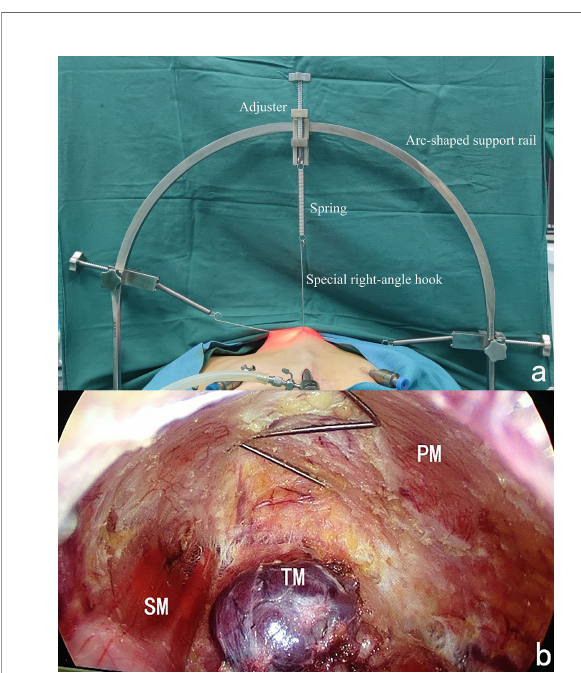
FIGURE 4 | (A) Outer schematic diagram of the use of the “ elastic stretch cavity builder ” . (B) Inner schematic diagram of the use of the “ elastic stretch cavity builder ” . PM, Platysma myoides; SM, Sternocleidomastoid muscle; TM, Thyroid tumor.